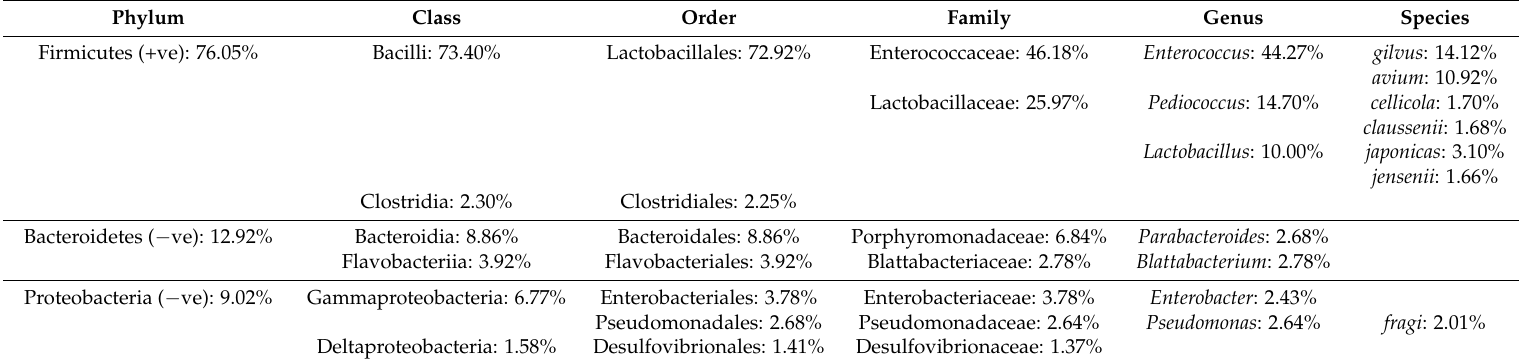
Table 2. Bacterial community (Top 7 identifications) in the whole body extract of S.